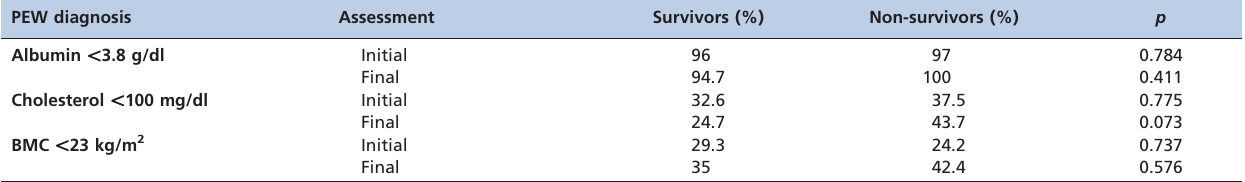
Table 5 - Prevalence of protein-energy wasting (PEW) (malnutrition) based on the International Society of Nutrition and Renal Metabolism (ISRNM) diagnosis at the initial and final